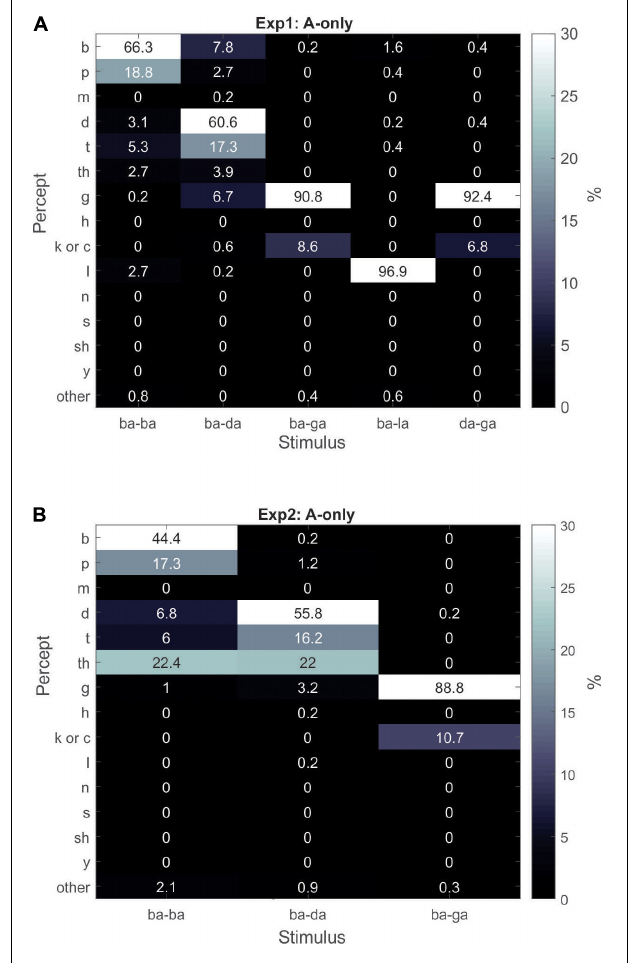
FIGURE 4 | Gray-scale matrix depicting percentages of percepts in response to A-only superimposed stimuli for Experiment1 (A) and Experiment2 (B) .